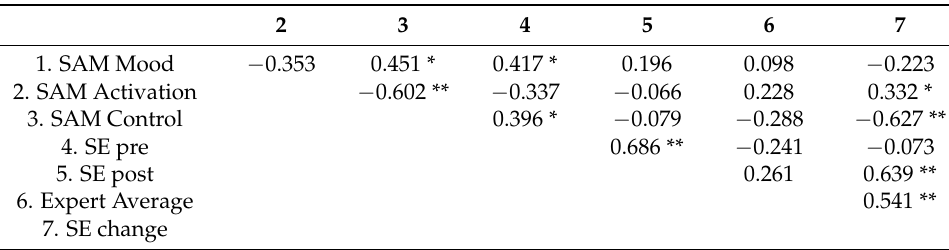
Table 3. Bivariate correlations between items of SAM, SE, and Expert